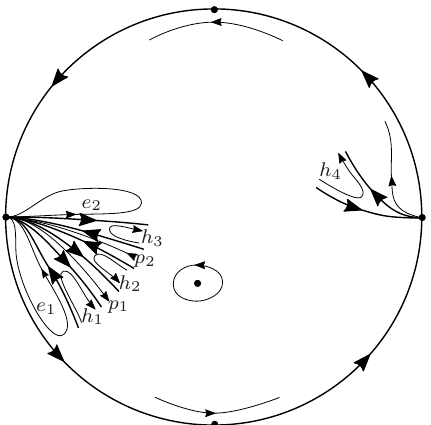
Figure 6 - The phase portrait of system (1) near the singular points.